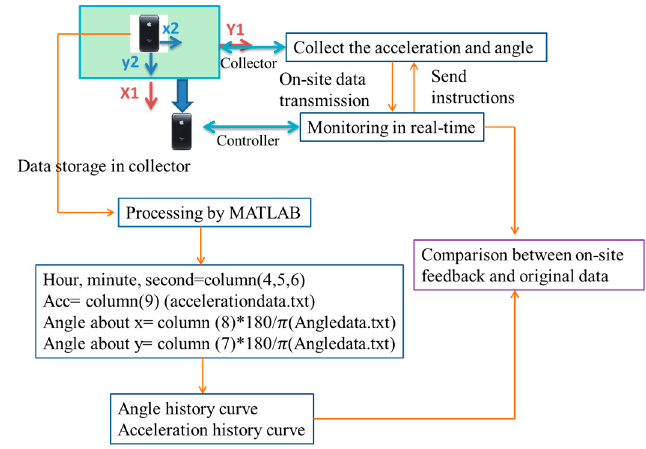
Figure 16. Algorithm of side-span hoisting.